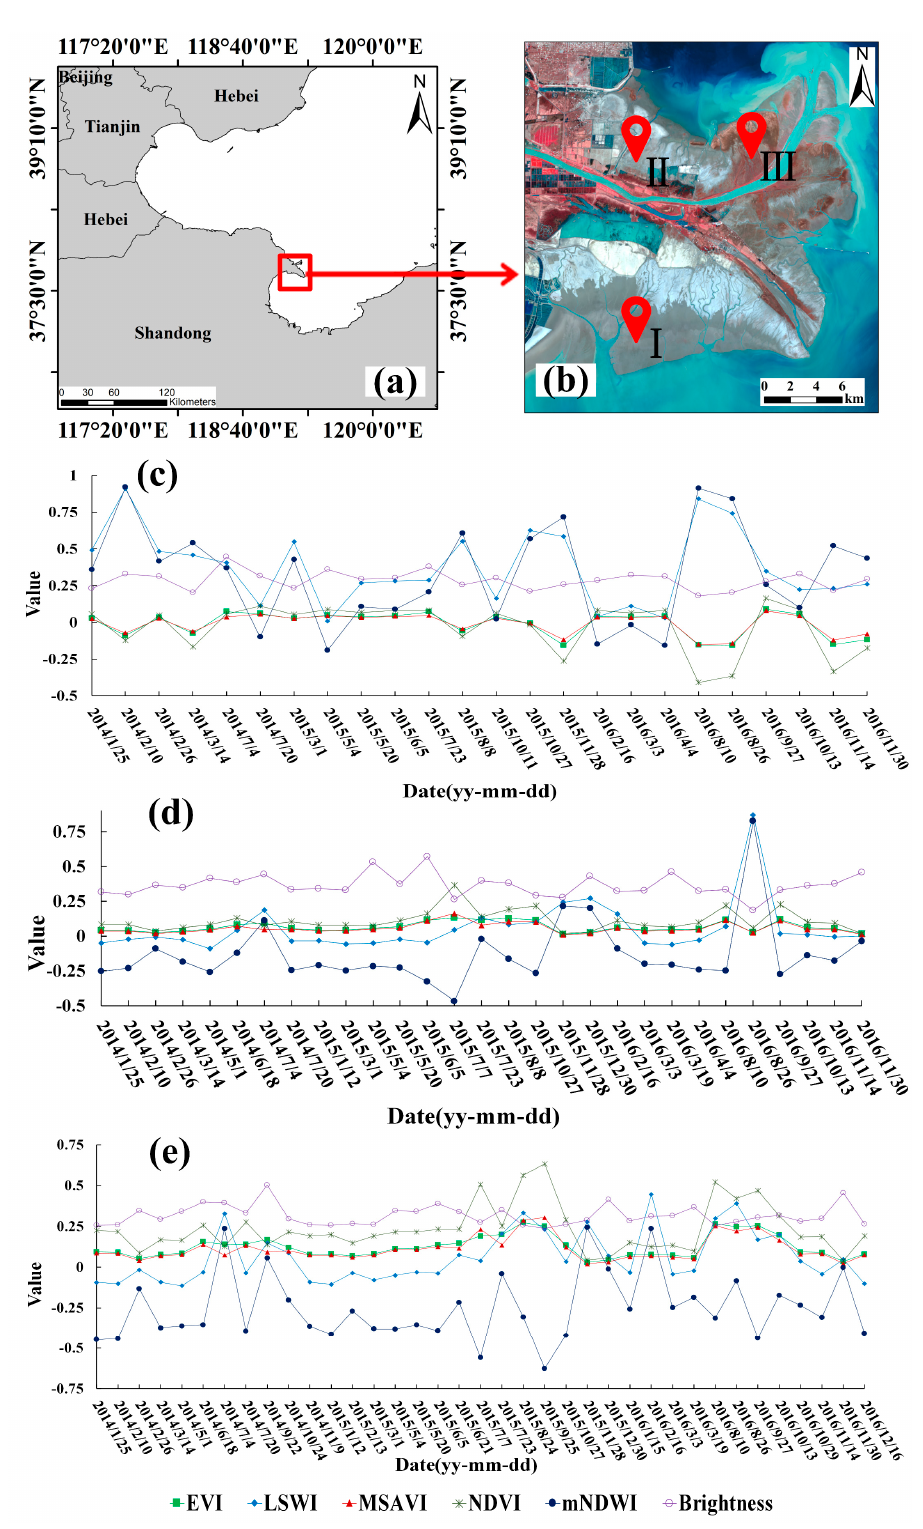
Figure 5. Temporal profile of Enhanced Vegetation Index (EVI), Land Surface Water Index (LSWI), Modified Soil-Adjusted Vegetation Index (mSAVI), Normalized Difference Vegetation Index (NDVI), Modified Normalized Difference Water Index (mNDWI) and soil brightness derived from Landsat OLI imagery archive at the selected tidal flat sites ( b ) of Yellow River Delta ( a ); ( c – e ) are corresponding to intertidal flat (I), supratidal barren flat (II) and vegetated flat (III),